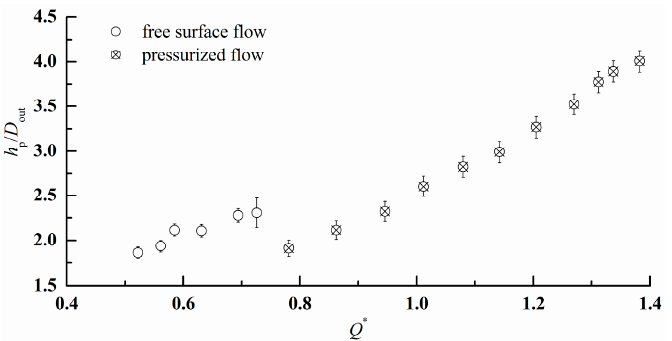
Figure 8. Variation of Q a / Q w with Q* for s = 0.93 m.